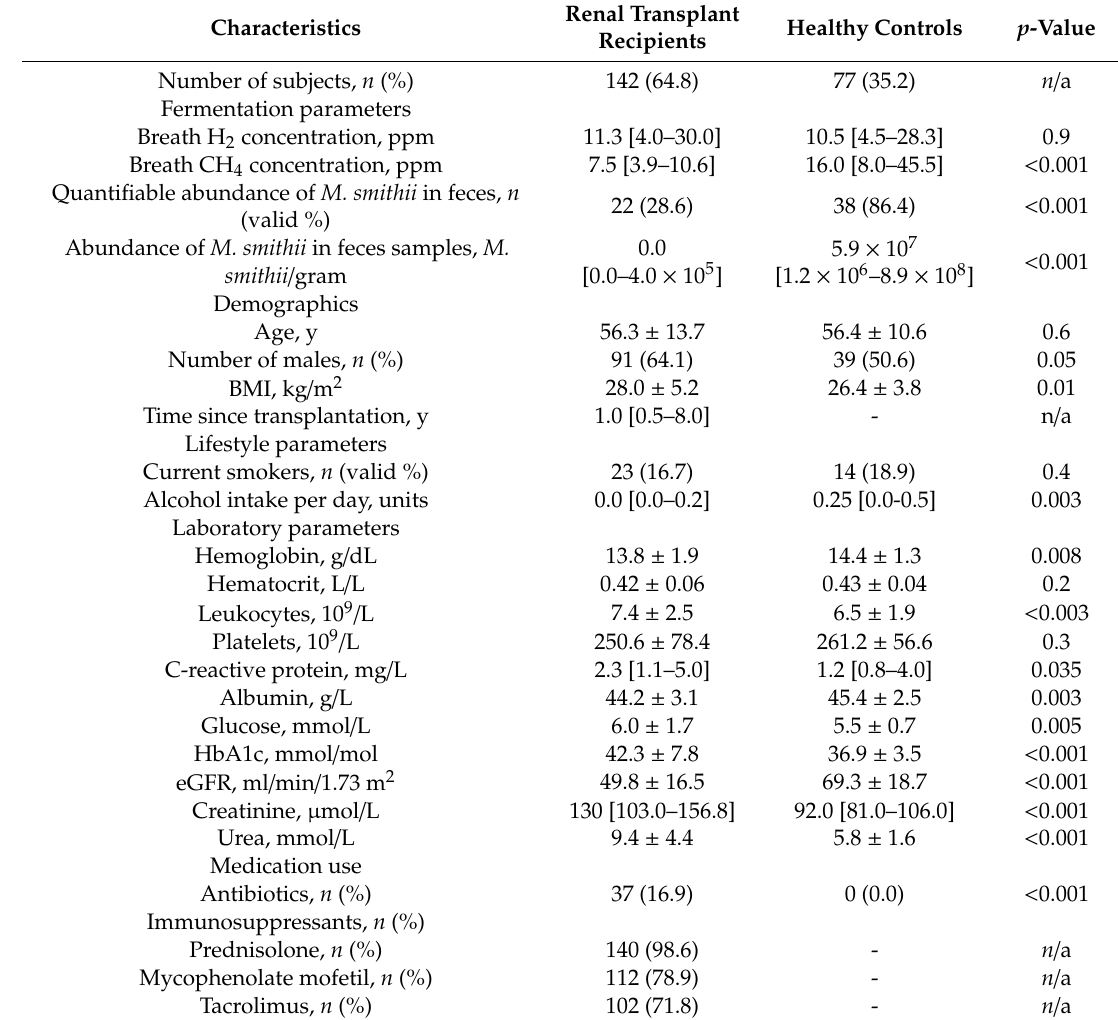
Table 1. Baseline